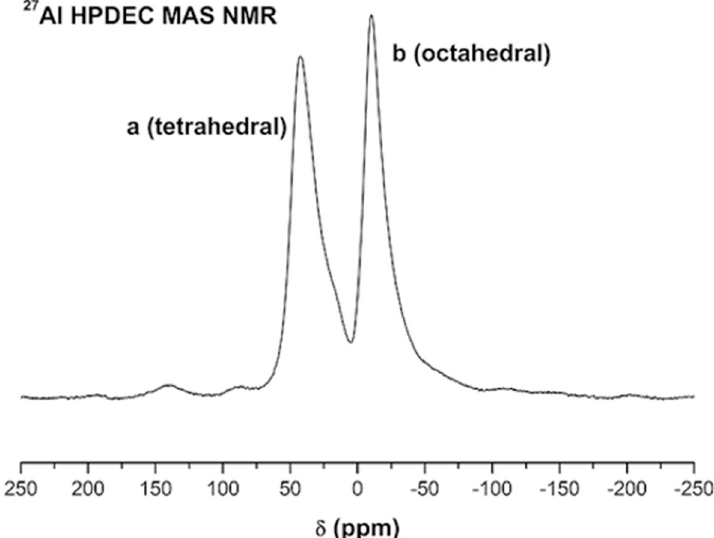
Figure 9. 27 Al high-power decoupled (HPDEC) magic-angle spinning (MAS) nuclear magnetic resonance (NMR) spectrum of the SAPO-CHA (Reprinted from European Journal of Inorganic